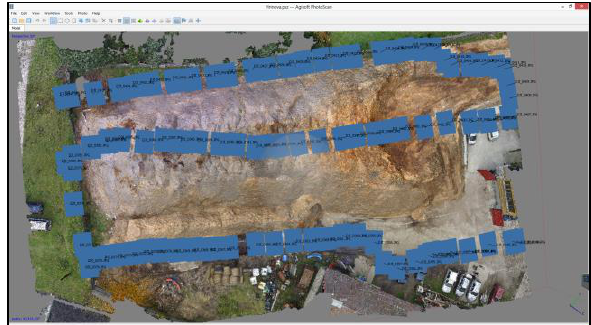
Figure 2. Example of flight path shown by blue rectangles that represent the photo positions (Hriňová)